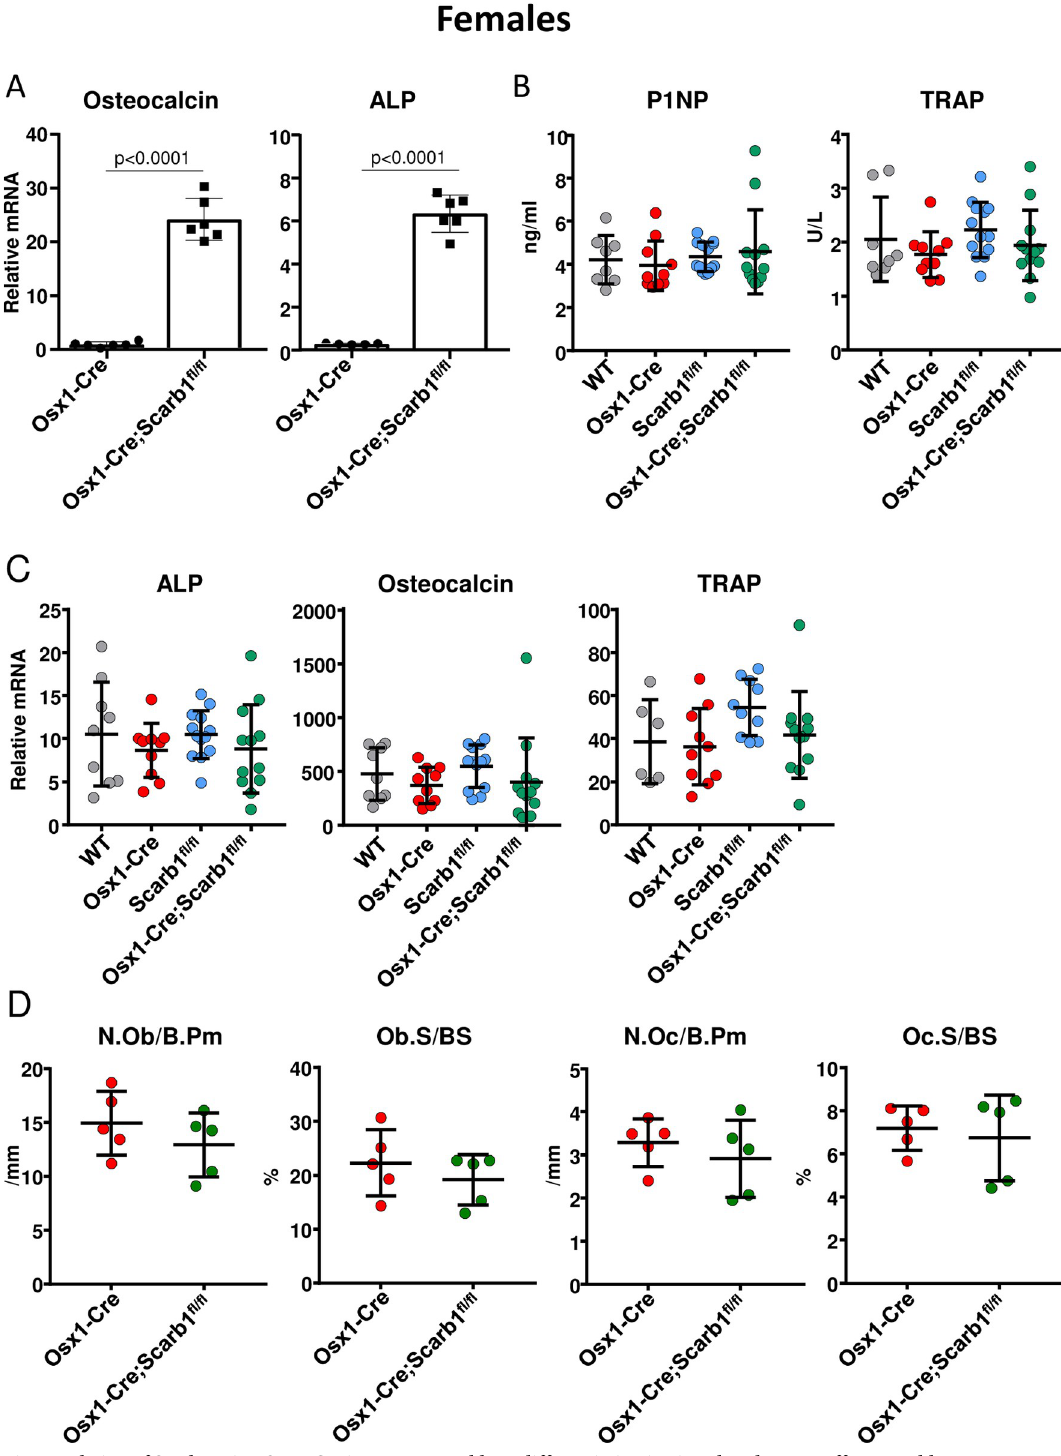
Fig 8. Deletion of Scarb1 using Osx1-Cre increases osteoblasts differentiation in vitro, but does not affect osteoblasts or osteoclasts in vivo. (A) The expression of osteocalcin and alkaline phosphatase was quantified with RT-PCR in calvaria-derived osteoblasts from new born Osx1-Cre (n = 5) and Osx1-Cre;Scarb1 fl/fl mice (n = 5) cultured for 21 days. Transcripts were normalized to the housekeeping gene MRPS2. Data analyzed by student t-test. (B) Measurement of bone remodeling markers in the serum of 6-month-old female mice [WT n = 8; Osx1-Cre n = 10; Scarb1 fl/fl n = 13; Osx1-Cre;Scarb1 fl/fl n = 12], P1NP, N-terminal propeptide;